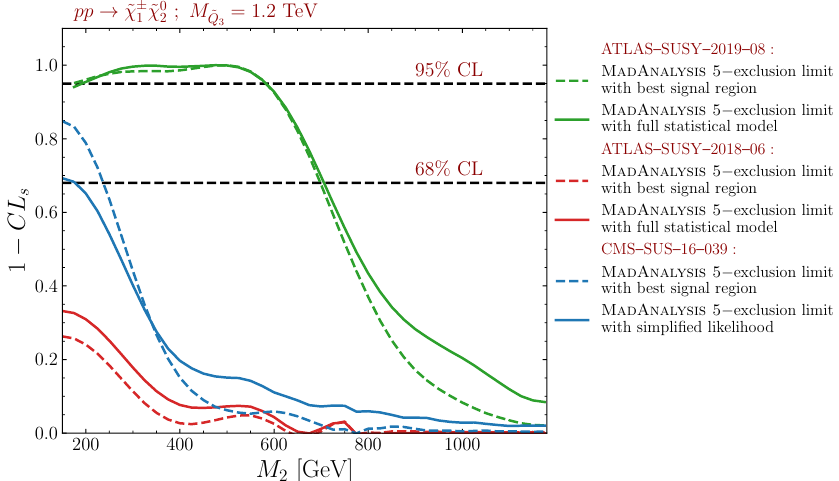
Figure 12: 1 − CL = 60 GeV and µ = 1.6 TeV. Full lines are with, dashed lines without SR com- M 1